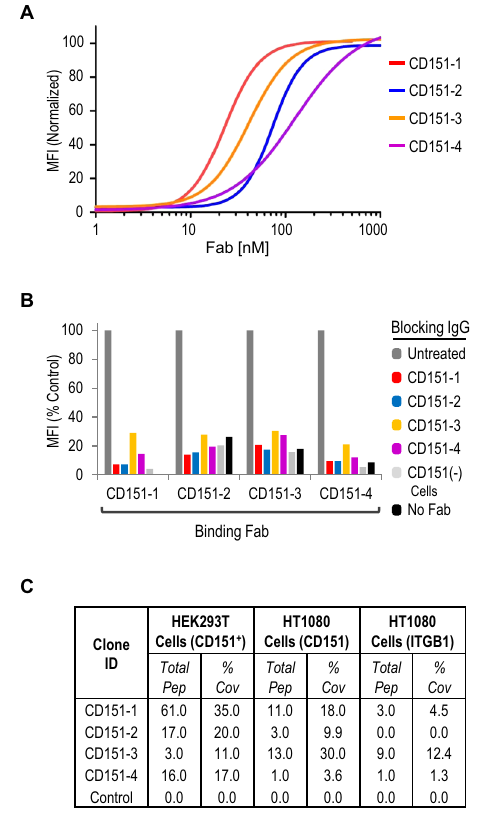
Fig. 5 Characterization of anti-CD151 Abs derived from CellectSeq. A Dose response curves for anti-CD151 Fabs assessed by fl ow cytometry fl uorescence (y-axis) using HEK293T-CD151 + cells. The MFI signals were subtracted from background Fab binding to HEK293T-CD151 − cells and normalized to the highest concentration value for each sample. Data a representative of n = 2 biologically independent experiments. B Blocking of anti-CD151 Fabs (x-axis) binding to HEK293T-CD151 + cells by indicated IgGs, assessed by fl ow cytometry fl uorescence (y-axis). Data a representative of n = 2 biologically independent experiments. C